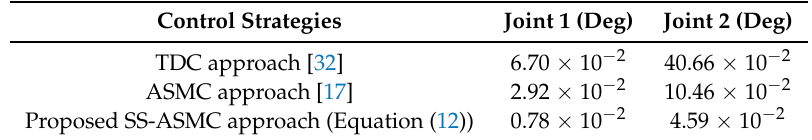
Table 1. The root-mean-square (RMS) tracking errors for sinusoidal command joint angle